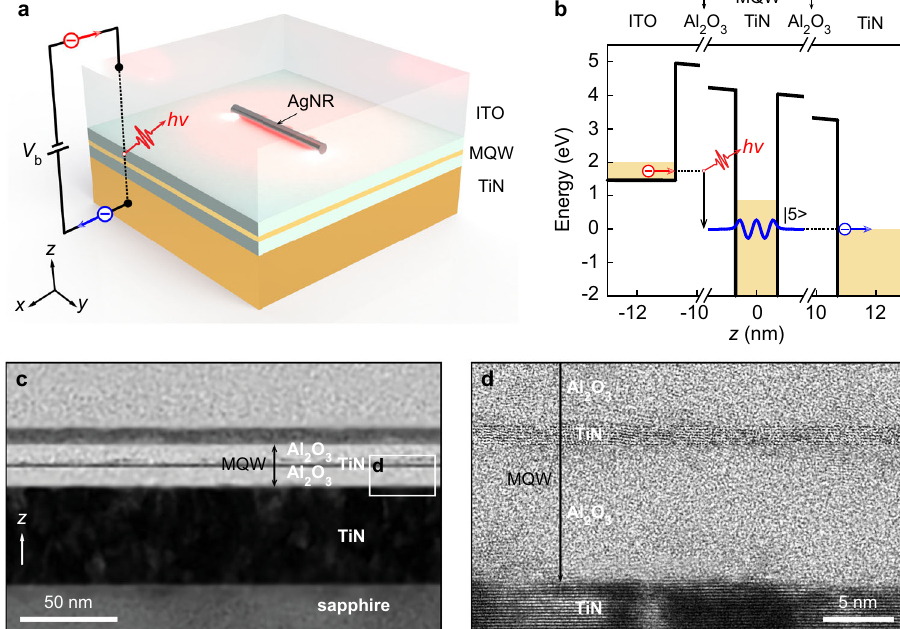
Fig. 1 RIETs enabled by an MQW for highly-ef fi cient electrically-driven SP sources. a Schematic drawing of the electrically-driven SP source (not to scale). An insulating MQW junction is biased via the upper conducting ITO and the lower metallic TiN. Electrons may inelastically tunnel through this MQW junction by coupling to a plasmonic mode of energy h ν supported by AgNRs on top of the junction. b RIET via the MQW junction. In this MQW, the resonant state |5 〉 is responsible for the RIET process that emits SPs with the energy h ν in the visible/NIR spectral range. c Transmission electron microscopy (TEM) cross-section of an MQW heterostructure. The layers on top of the MQW are the protective layers used only for TEM cross-section preparation during the focused ion beam (FIB) cutting process. d High-resolution TEM (HRTEM) image showing an enlarged view of the MQW.